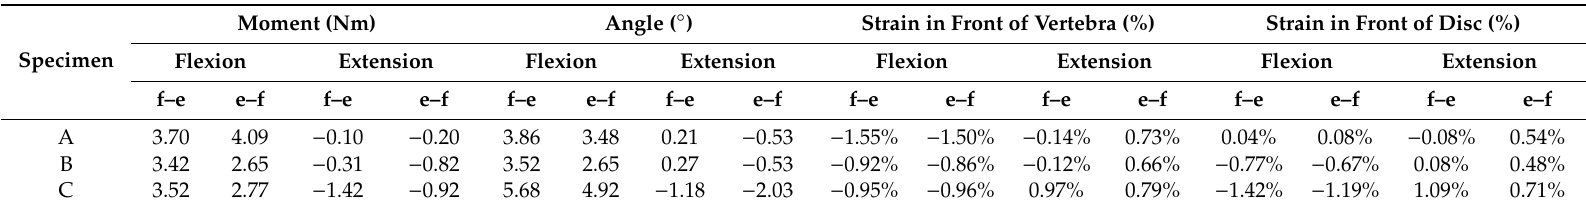
Table 3. The values of moment, angle between L4 and L5 and strain (in front of the vertebra and in front of the disc) in correspondence to the end of LZ and the beginning of EZ are reported in the range of angles corresponding to spine flexion and extension, both for the flexion-to-extension (f–e) direction and for the extension-to-flexion (e–f)